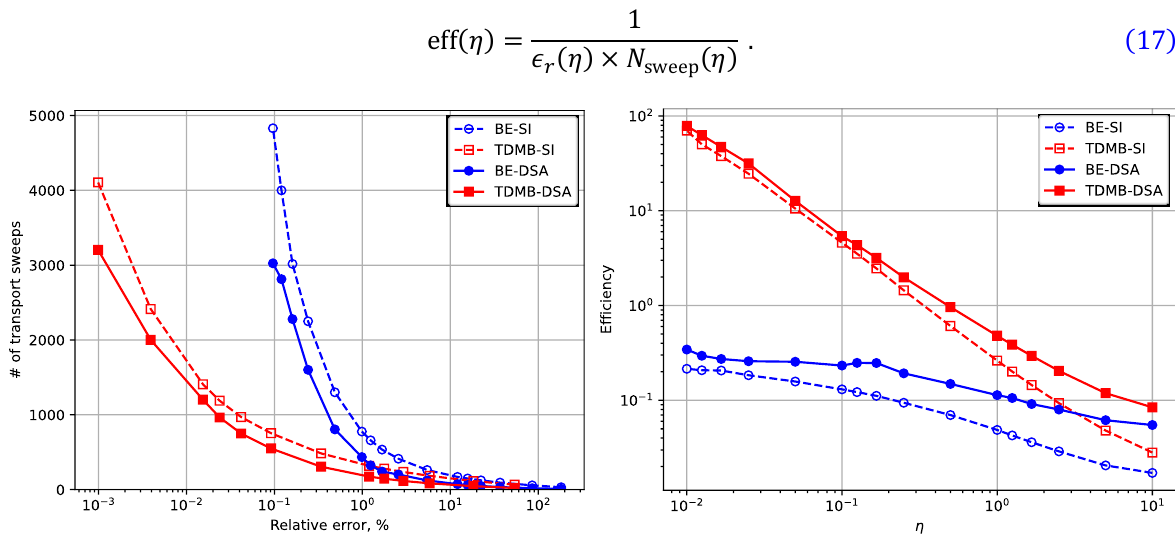
Figure 4. (Color online) (Left) number of transport sweeps required to achieve a certain accuracy and (right) efficiency of BE and TDMB in solving the second test